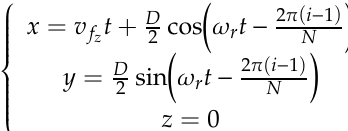
Figure 1. High-speed rotary ultrasonic elliptical milling (HRUEM) process with a four-flute end mill. The trajectories of the tool tips in the conventional milling (CM) process are composed of the feed motion of the table and the rotary motion of the tool. The Tool-Cartesian coordinate system is shown in Figure 1. The trajectories of tooltips in CM can be expressed